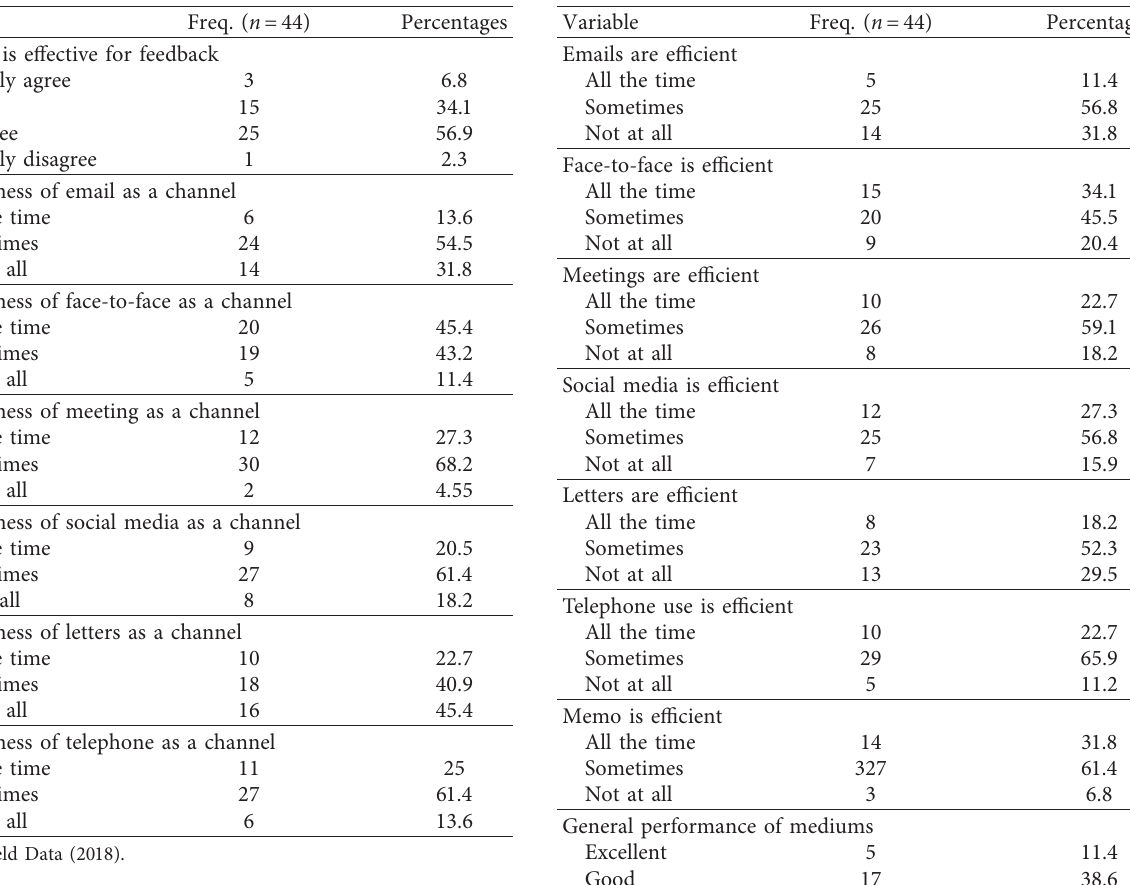
Table 5: Communication mediums effectiveness as examined by management.